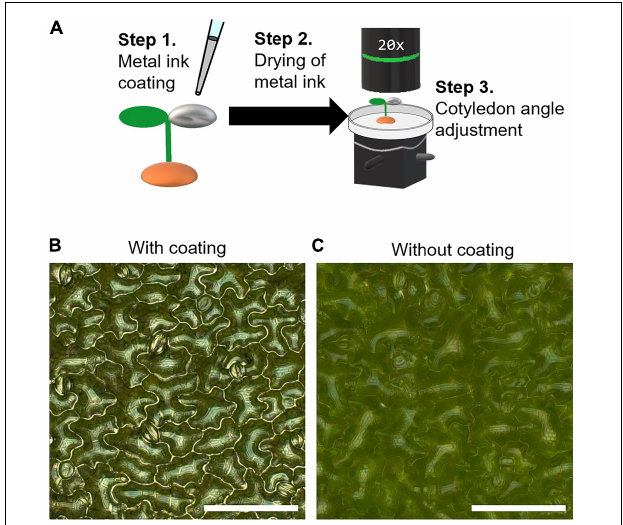
FIGURE 1 | Silver ink coating of cotyledon surfaces for visualization of cotyledon epidermal cells in Arabidopsis thaliana . (A) Schematic illustration